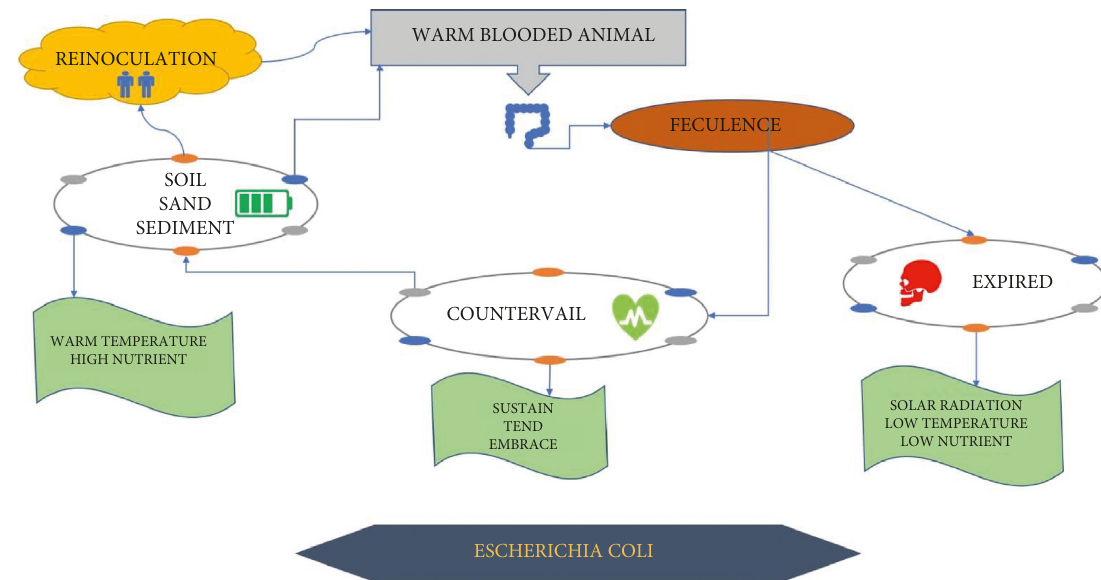
Figure 1: The growth of E. coli